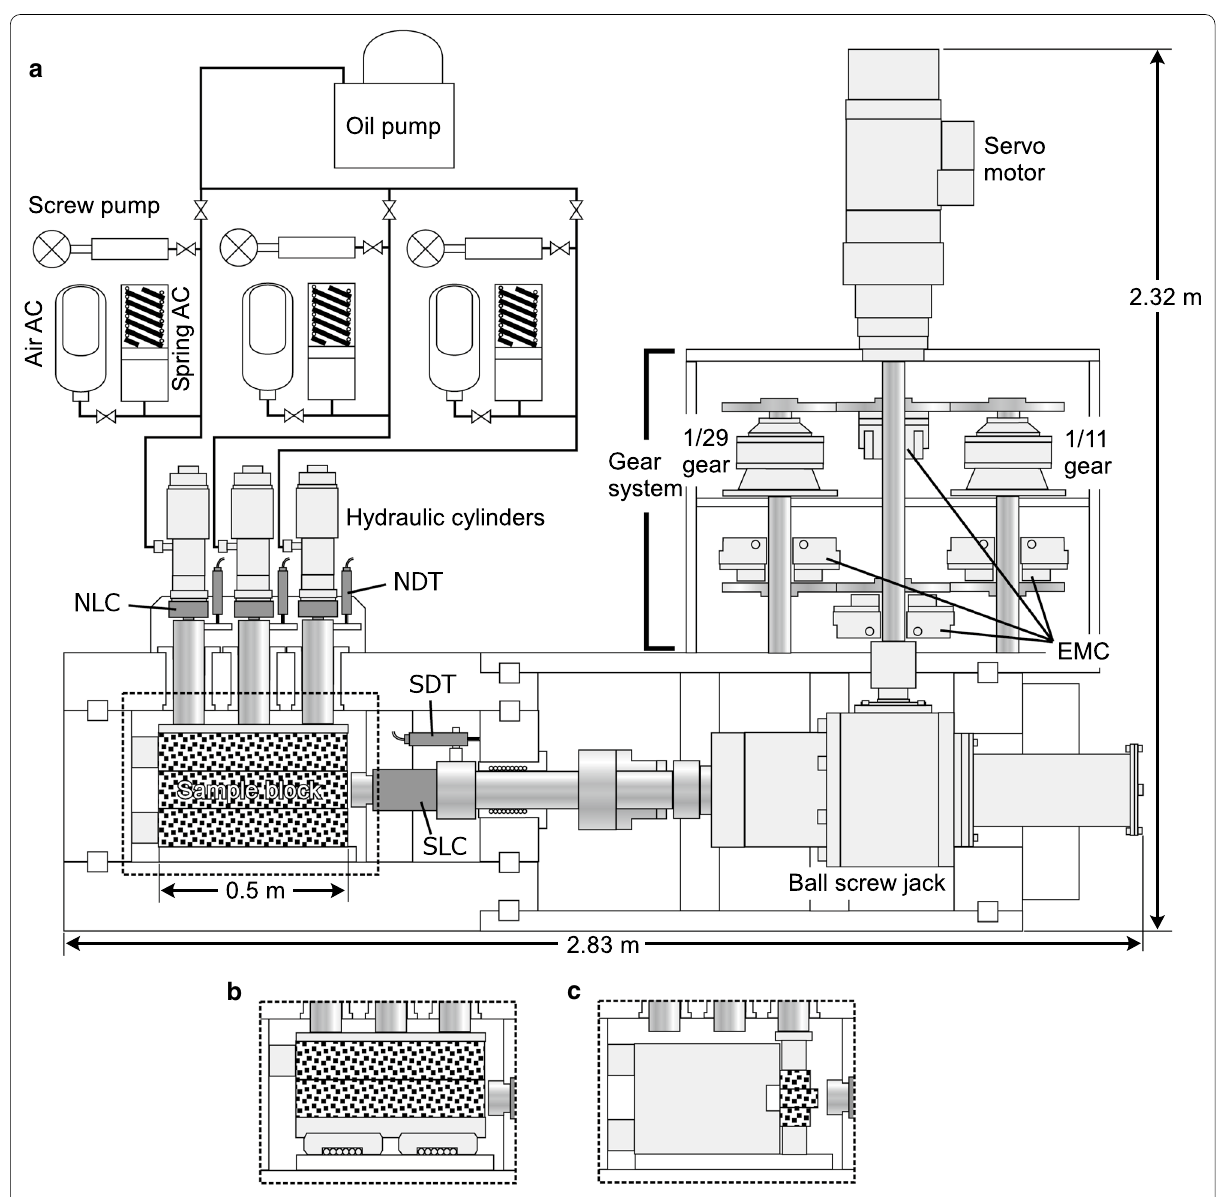
Fig. 3 The bi‑axial double‑direct shear‑loading apparatus (BASH). a Schematic diagram showing the bi‑axial compression apparatus built at CRIEPI, including a sample assembly in a double‑direct shear configuration for a 50‑cm‑long rock specimen. b Single‑direct shear sample assembly for long rock specimens. c Double‑direct shear sample assembly for short rock specimens used in this study. SLC, shear load cell; SDT, shear displacement transducer; NLC, normal load cell; NDT, normal displacement transducer; AC, accumulator; EMC, electromagnetic